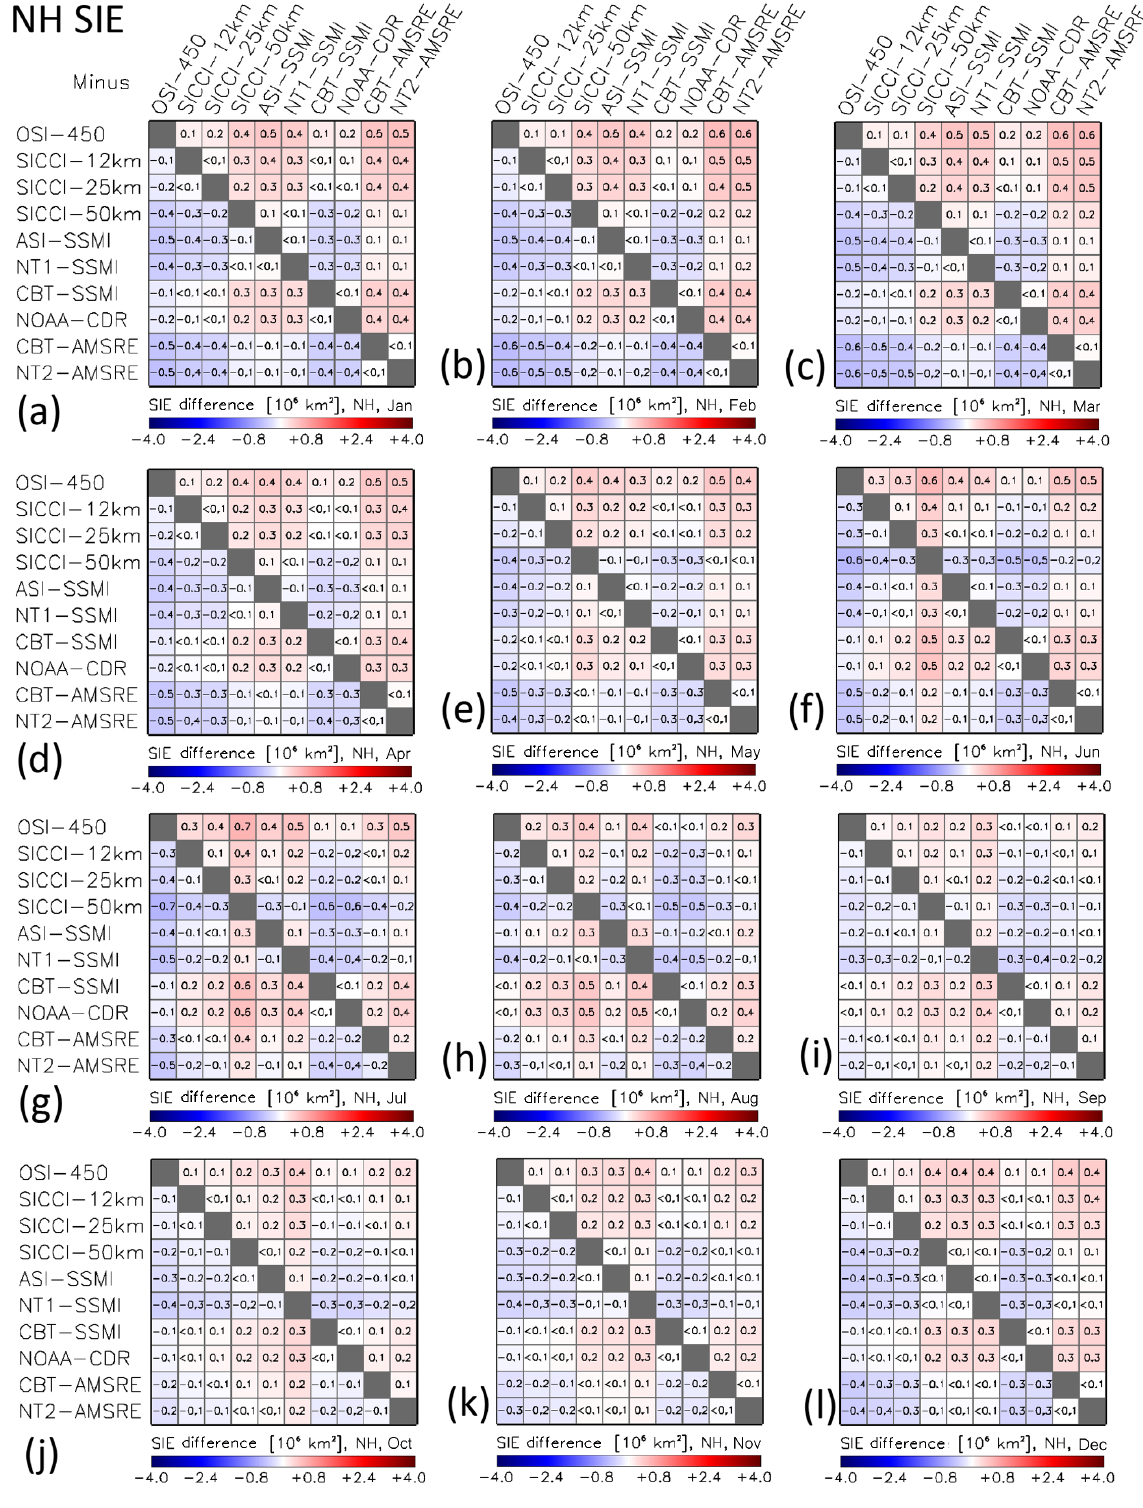
The Cryosphere, 13, 3261–3307,